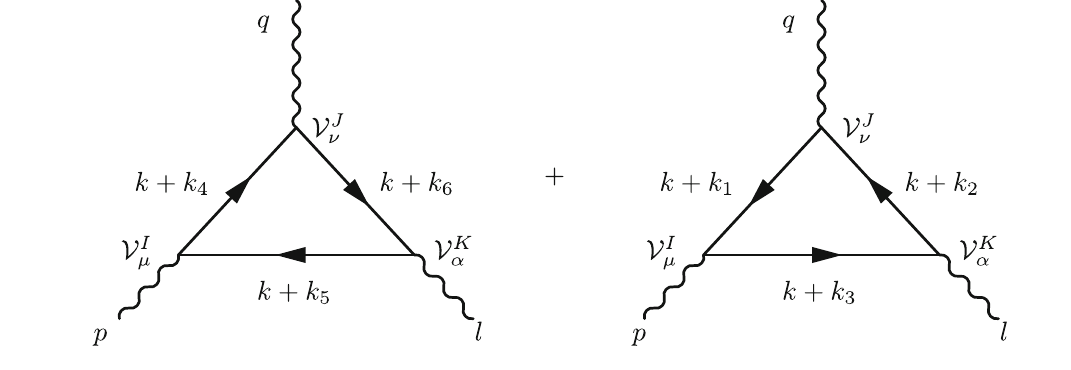
Fig. 2 The T IKJ μαν ( p , l , q ) triangle